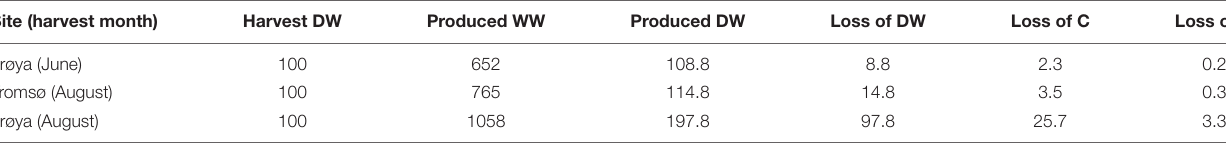
TABLE 7 | Export scenarios from kelp rigs for 100 tons harvestable dry matter per production season. Site (harvest